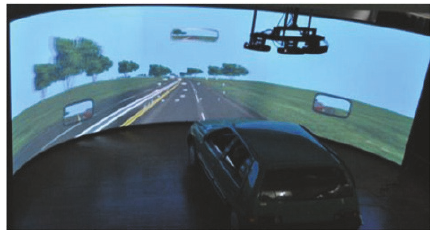
Figure 1: The KMRTDS driving simulator.